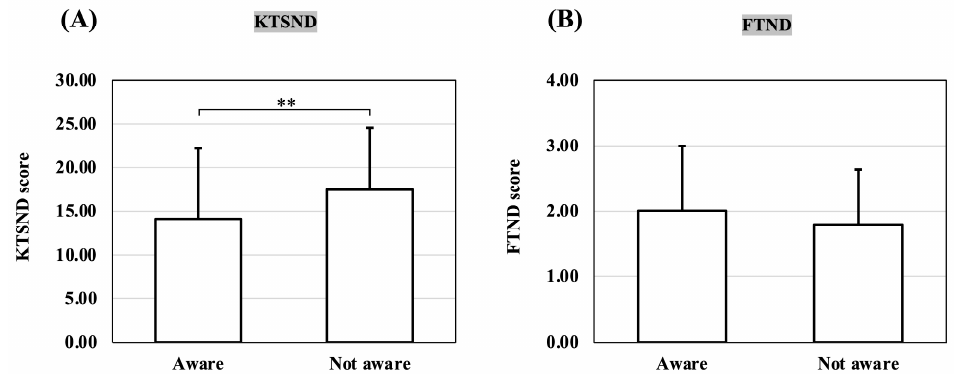
Figure 2. ( A ) Comparison of KTSND scores by awareness of smoking as a risk factor for COVID-19; ( B ) comparison of FTND scores by awareness of smoking as a risk factor for COVID-19. p -values are from t -tests. **, p < 0.01; KTSND, Kano Test for Social Nicotine Dependence; FTND, Fagerström Test for Nicotine Dependence; COVID-19, coronavirus disease 2019.